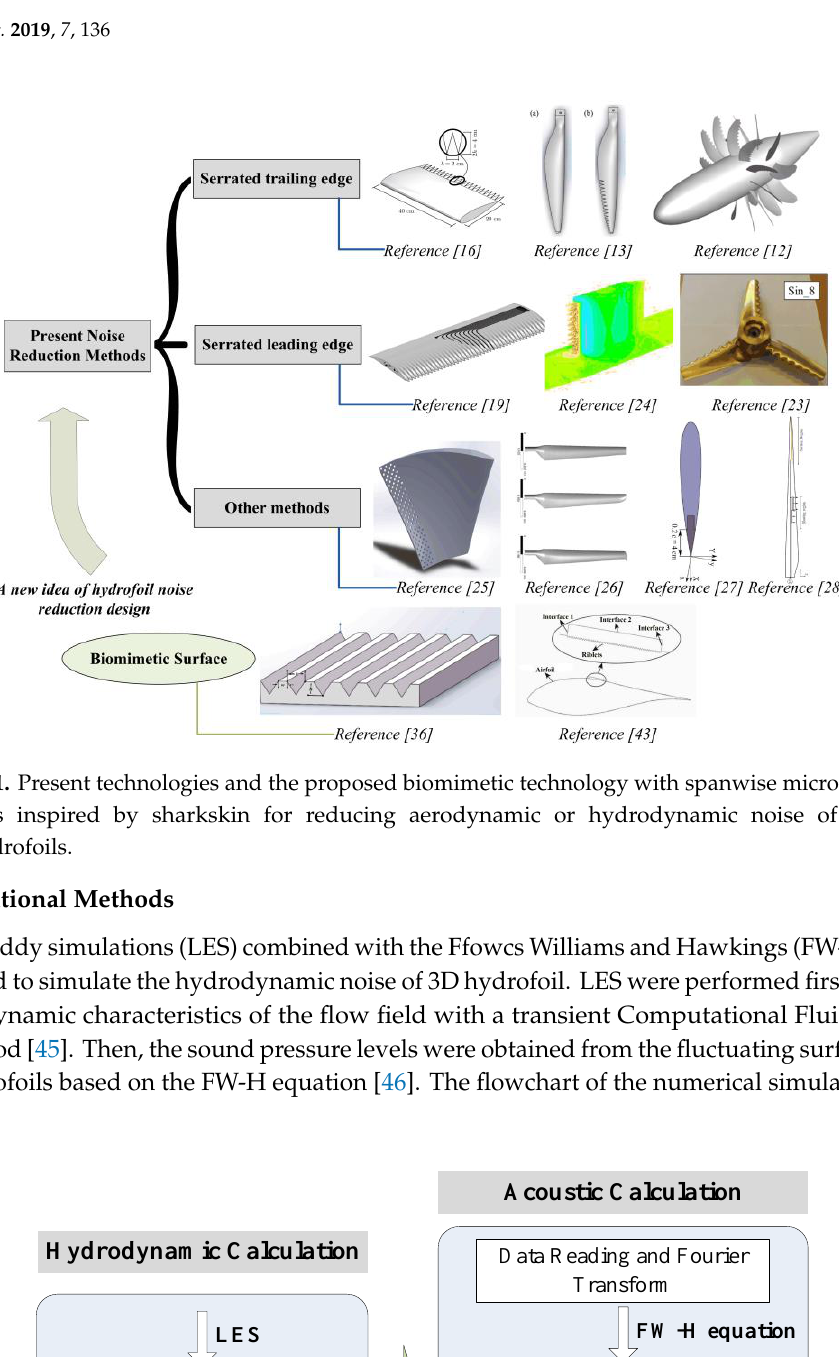
Figure 1. Present technologies and the proposed biomimetic technology with spanwise microgrooved surfaces inspired by sharkskin for reducing aerodynamic or hydrodynamic noise of airfoils and hydrofoils.